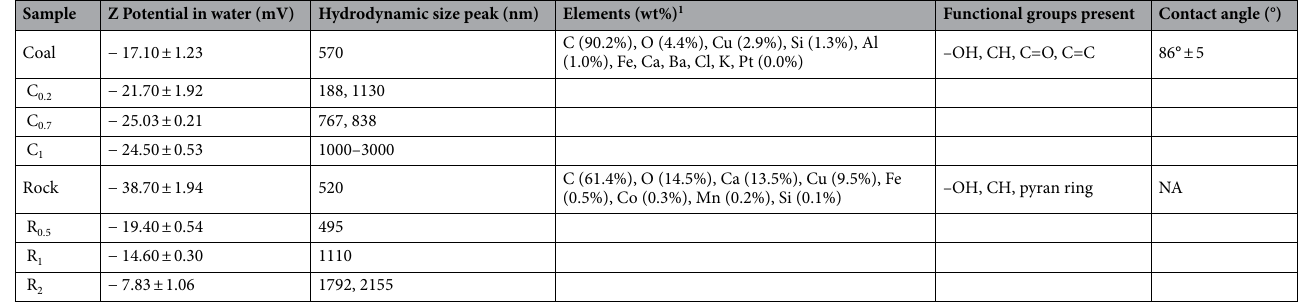
Table 1. Summary of respirable mining dust particles